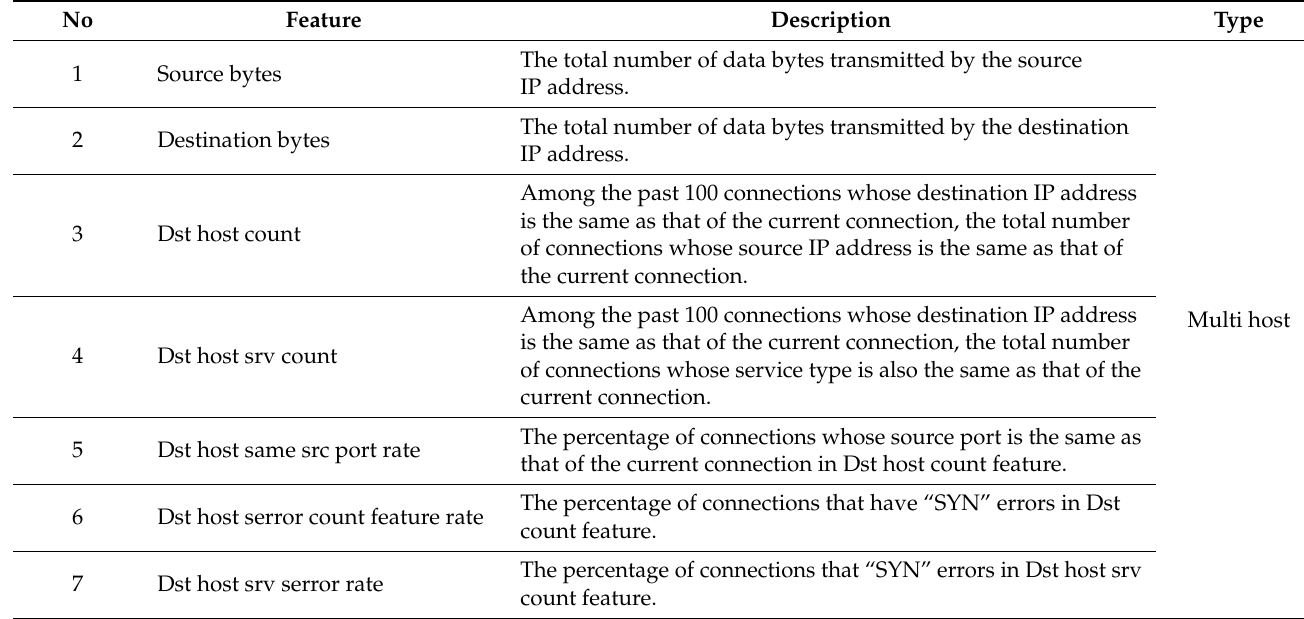
Table 4. Partial feature set used in the Kyoto dataset.